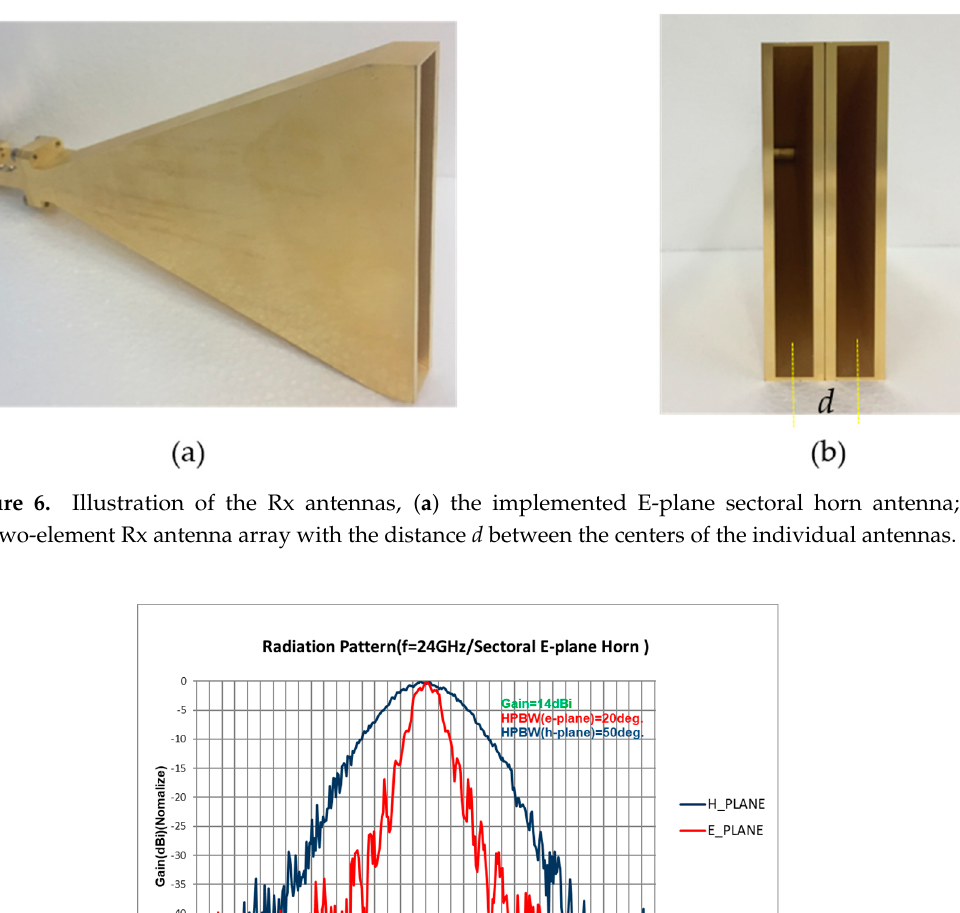
Figure 5. Simulated Tx Lens Horn Antenna Radiation Pattern.